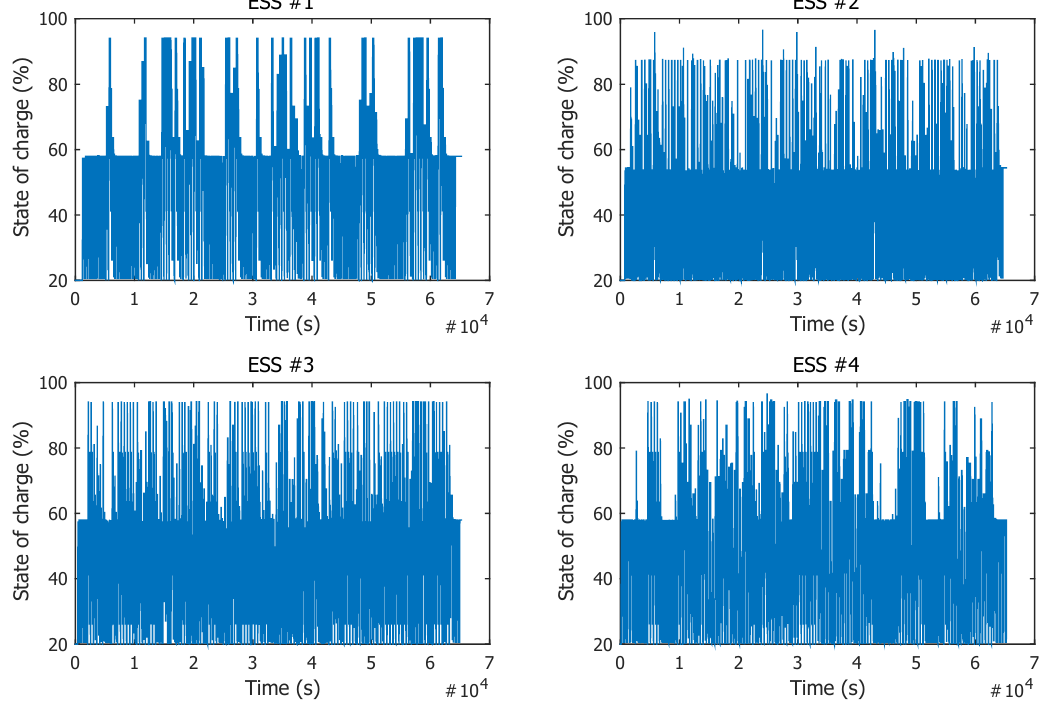
Figure 9. State-of-charge of each